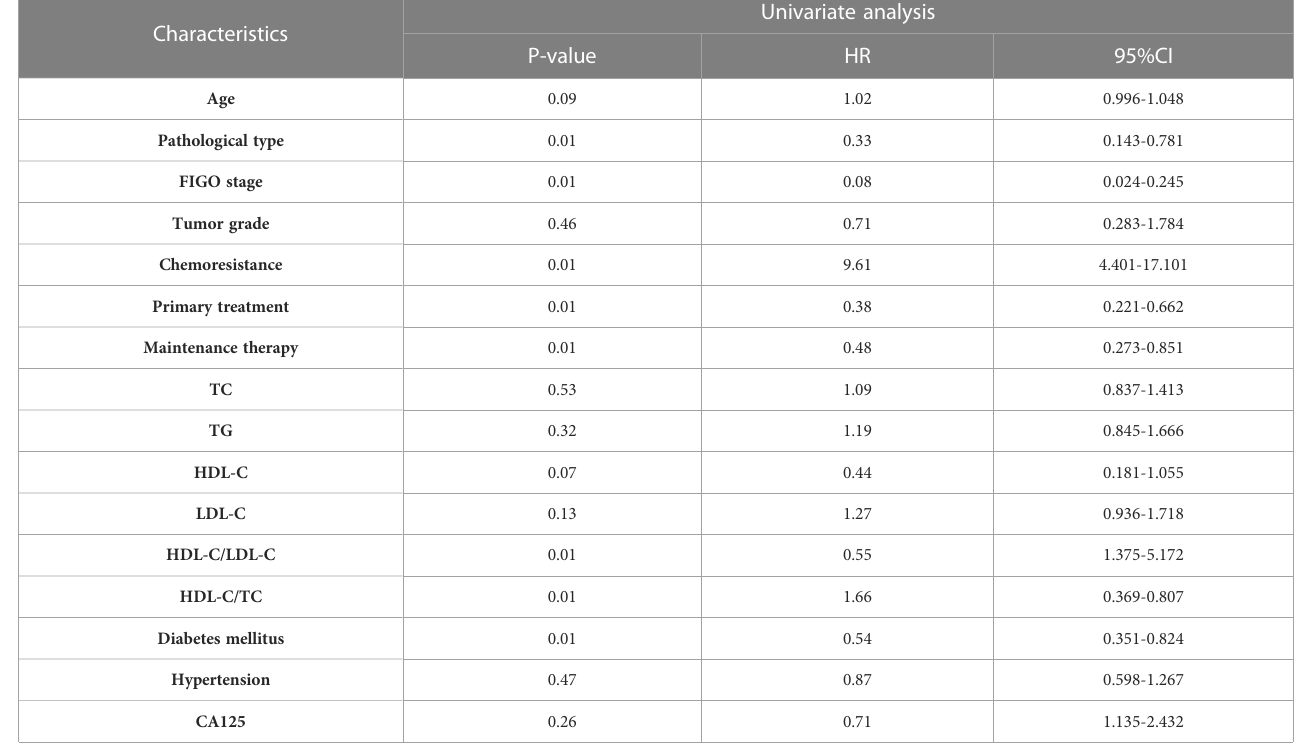
TABLE 4 Univariate survival analysis of OS in 249 patients with ovarian